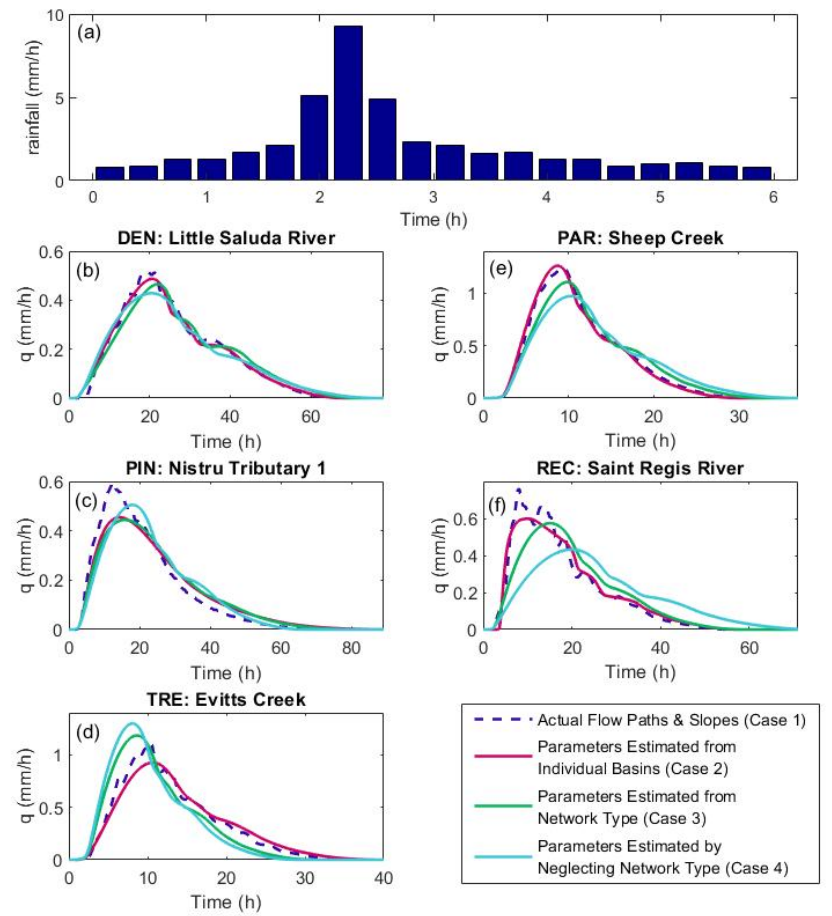
Figure 9. ( a ) Rainfall intensity for a 6-h SCS Type II storm and the resulting specific discharge hydrographs for an example basin of the ( b ) dendritic, ( c ) pinnate, ( d ) trellis, ( e ) parallel, and ( f ) rectangular types when the IUH is determined using the four methods described in the legend. The basins are the same as those in Figure 1.